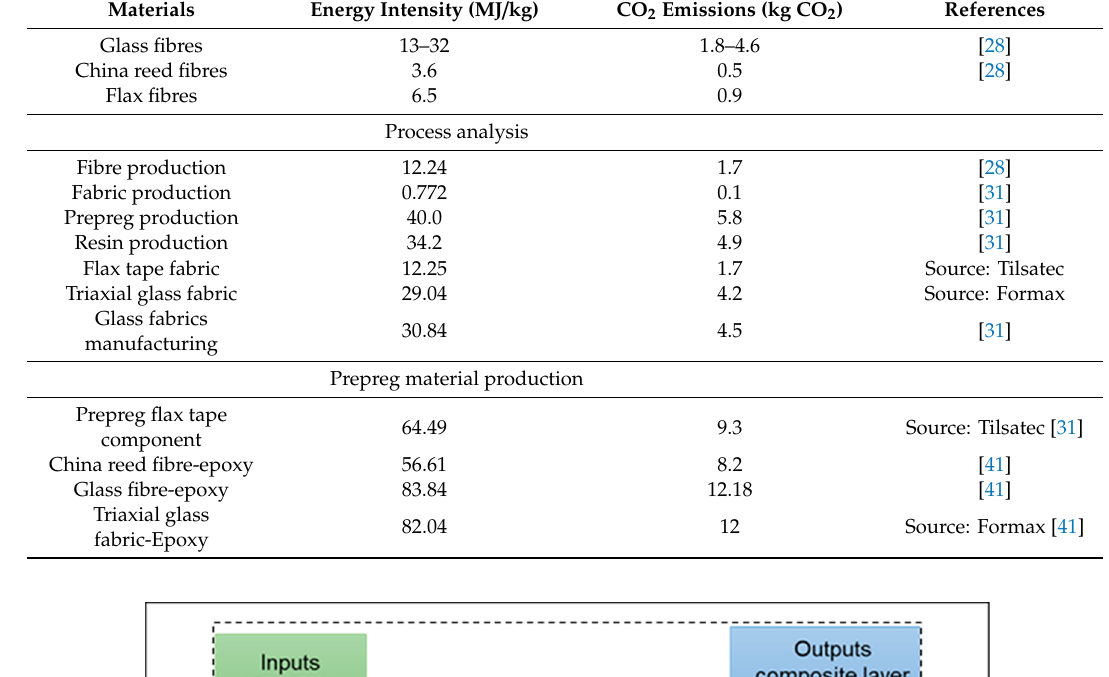
Table 1. Energy consumption for various materials and processes.